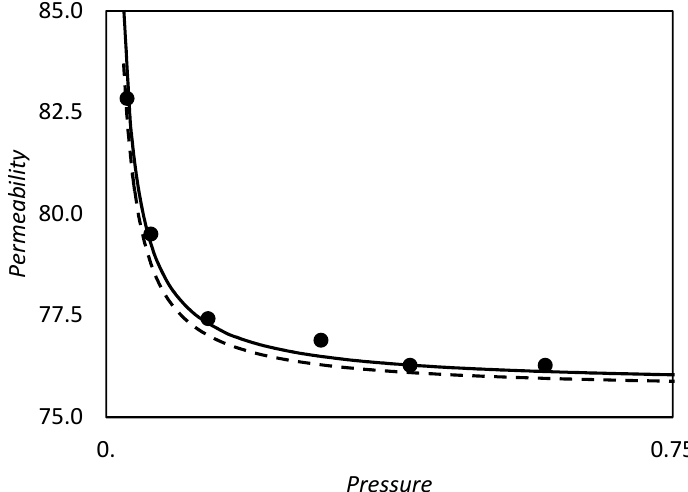
Figure 16. Oxygen permeability in a poly-dimethyl siloxane (PDMS) membrane with metallo-porphyrin fixed carrier. Circles are experimental data from Ohynagi et al. [26], n = 228 and n = 1 for continuous and broken line, respectively. Permeability is in (1 × 10 − 9 × cm 3 · cm/(cm 2 · s · atm)), pressure is in (atm).